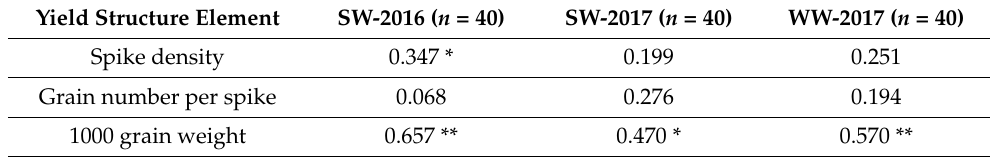
Table 5. Relationship of wheat yield to yield structure elements—simple correlation coefficients. Yield Structure Element